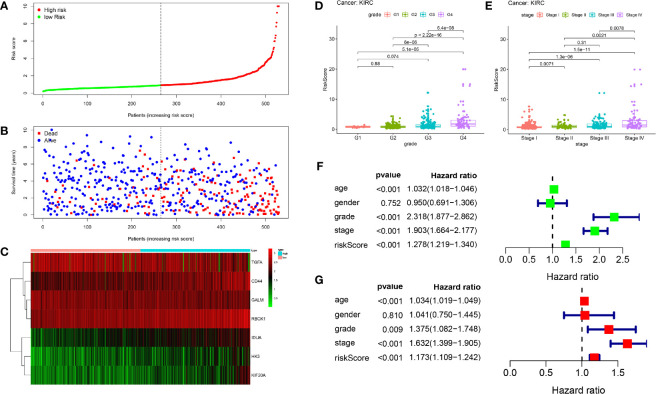
Prognostic analysis of seven-gene signature in the training set. The dotted line represented the median risk score and divided the patients into low- and high-risk group. (A) The curve of risk score. (B) Survival status of the patients. More dead patients corresponding to the higher risk score. (C) Heatmap of the expression profiles of the seven prognostic genes in low- and high-risk group. (D, E) The higher the risk score, the higher the tumor grade and stage. (F, G) Univariate and multivariate Cox regression analysis identified the indicators that significantly correlated with OS and revealed the independent prognostic factors.